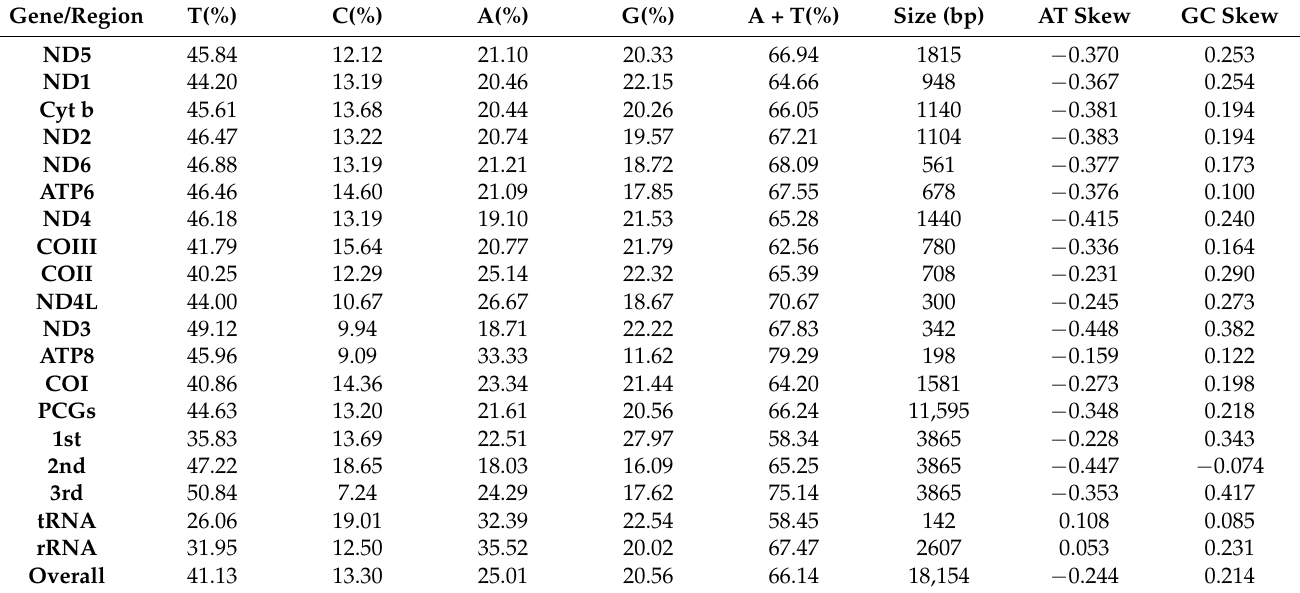
Table 3. Nucleotide composition in different regions of mitochondrial genome of H.bowerbanki